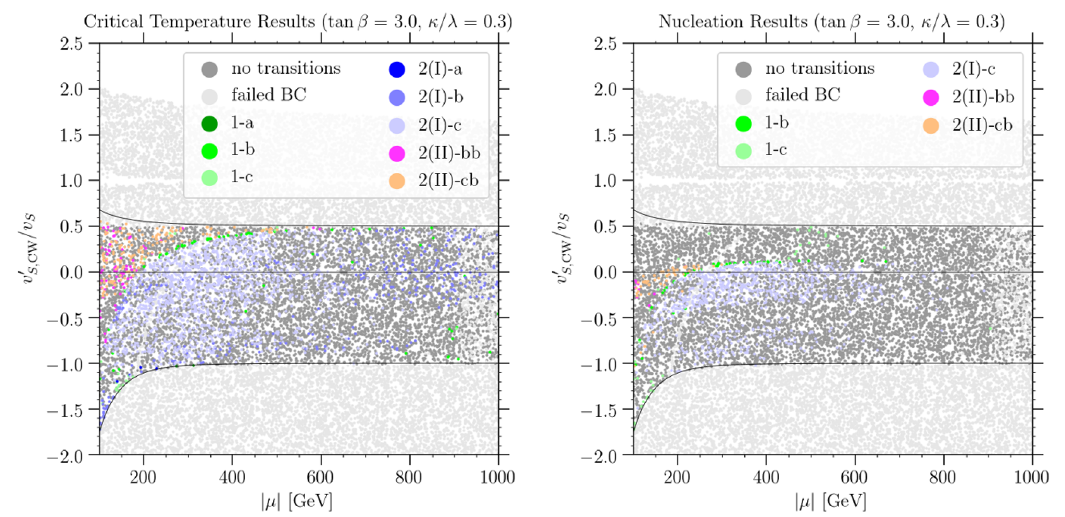
Figure 9 . Same as figure 4, but for tan β = 3 . 0 and κ/λ = 0 . 3